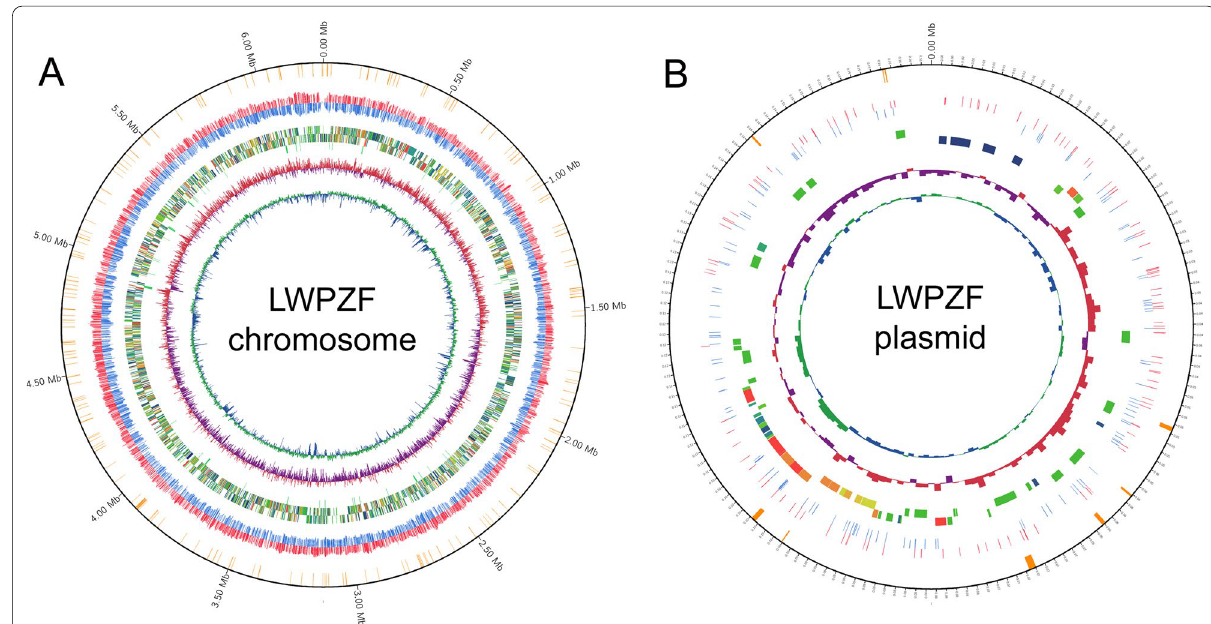
Fig. 3 Circular genome map of P. putida LWPZF. A Genetic map of the chromosome. B Genetic map of the plasmid. The first circle represents distribution of genes belonging to restrictive modification system. The second and third circles depict the base modification distribution of positive and negative chains, respectively. The fourth and fifth circles show the CDS distribution of positive and negative chains, respectively. The sixth circle represents ncRNA. The seventh and eighth circles represent GC skew and GC content, respectively